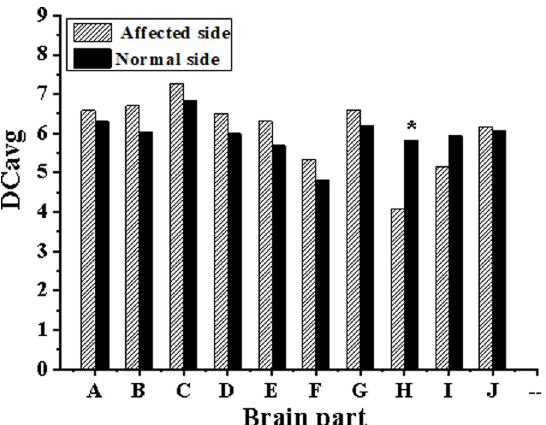
Fig 9. Comparison on DCavg values different brain parts in the affected and normal side. A–J referred to the semi- oval center, the posterior horn of the lateral ventricle, the forelimb of the internal capsule, knee of internal capsule, the hind limbs of internal capsule, lenticular nucleus, the brain stem, the infarct central area, the marginal area of infarct focus, and the normal area around the focus, respectively. ( �� indicated the difference was huge in contrast to the affected side ( P <